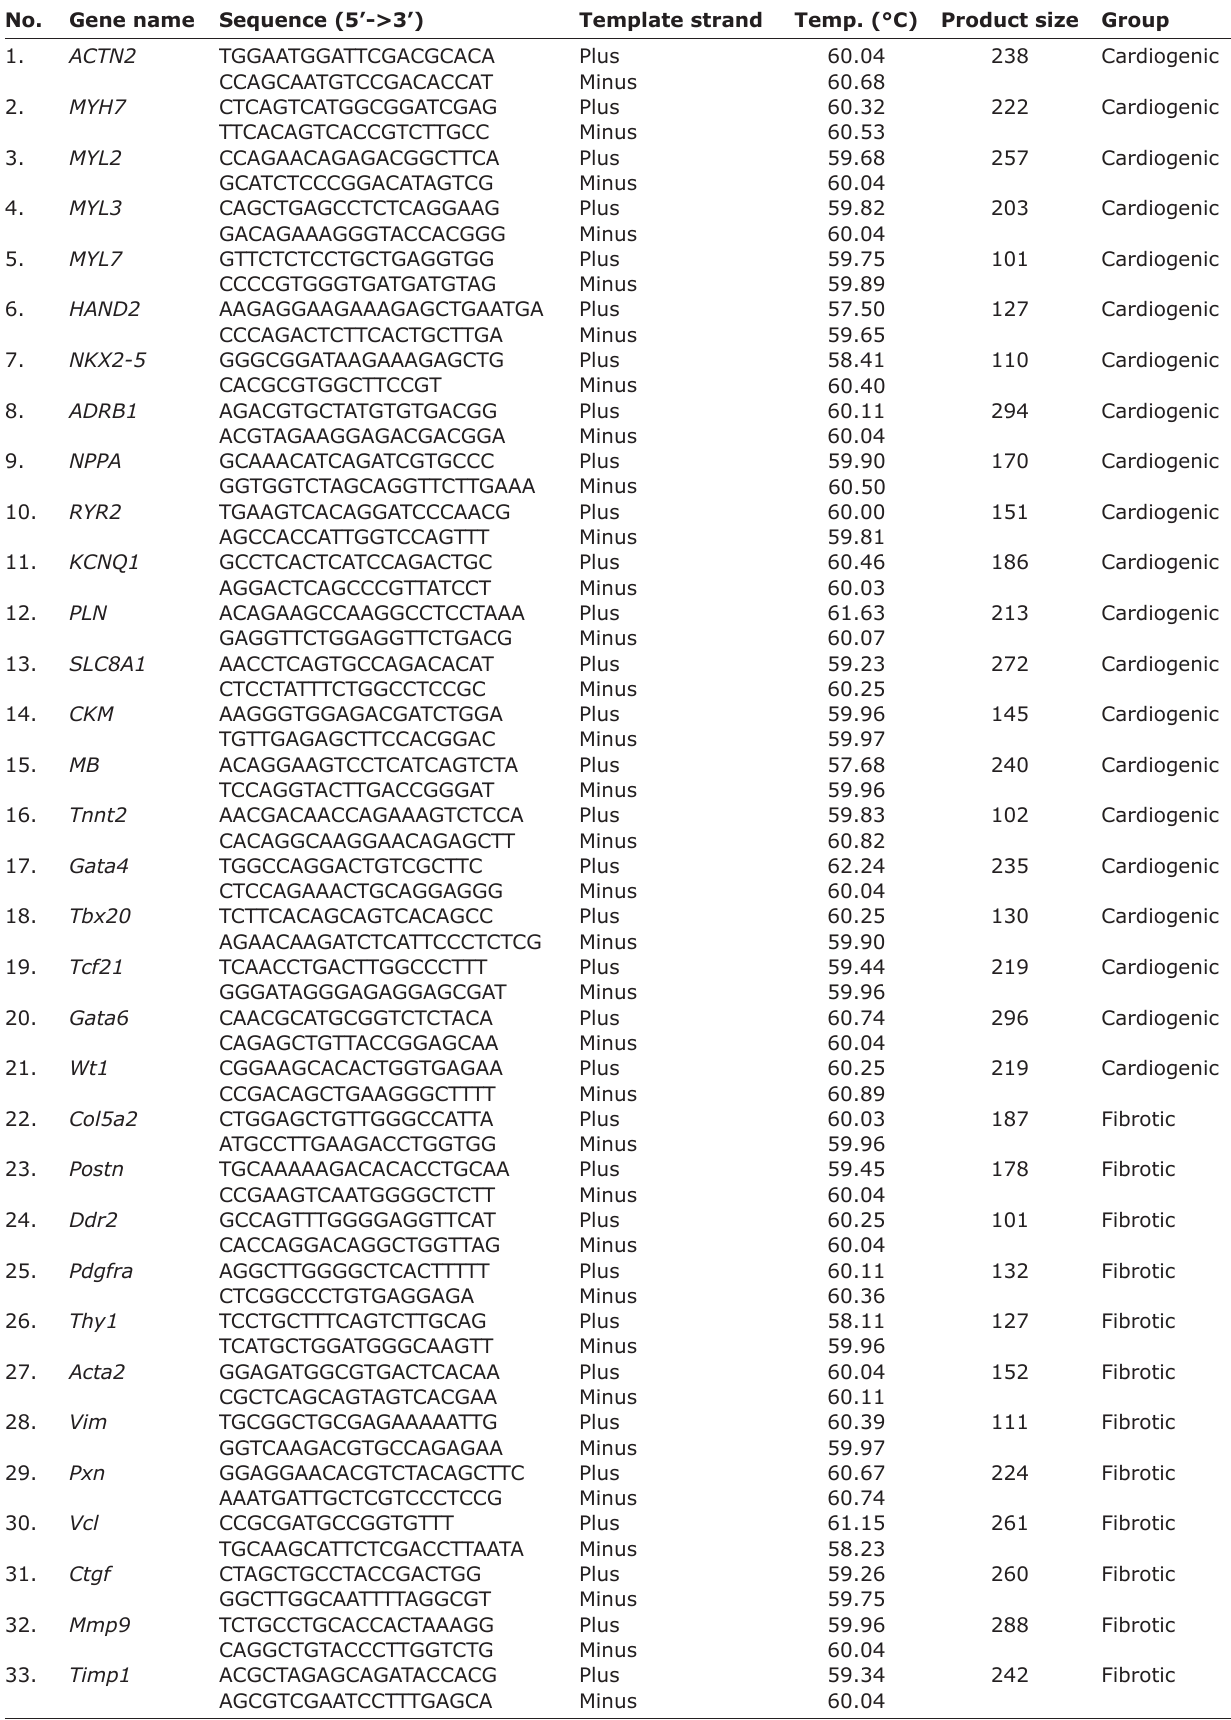
Table-1: List of polymerase chain reaction